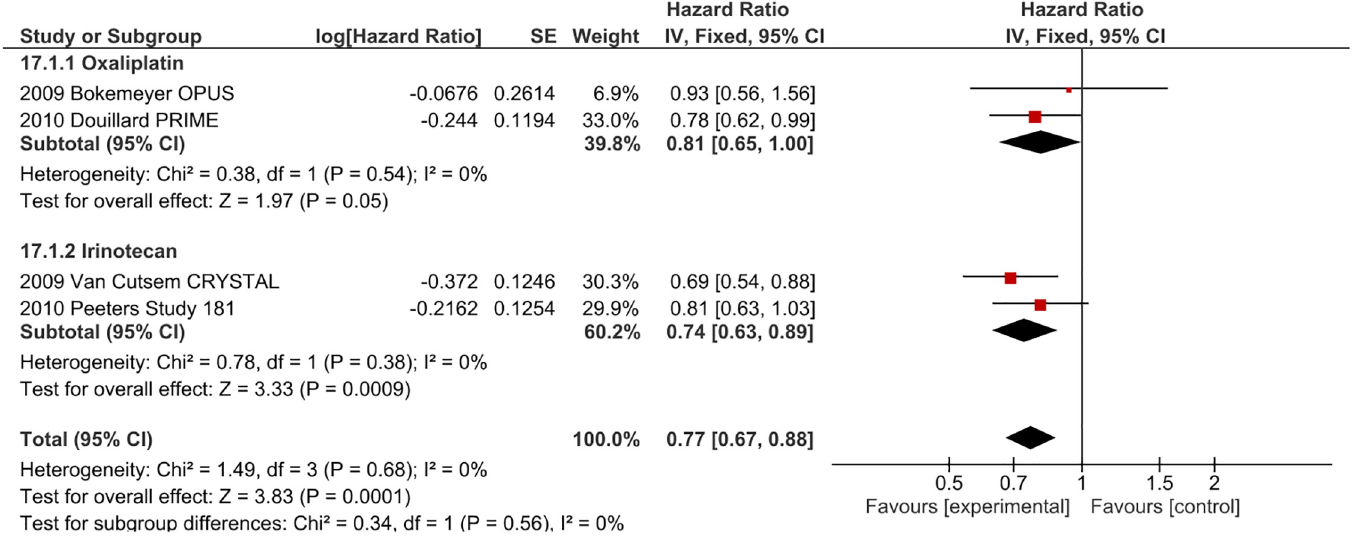
Fig 5. OS outcomes for EGFR-I by chemotherapy backbone — extended RAS